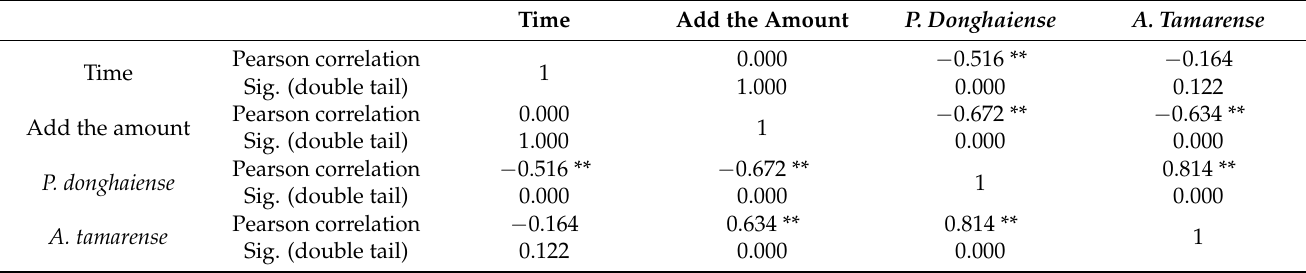
Figure 2. Effects of different proportions of fermentation broth on the growth of Prorocentrum don- ghaiense.